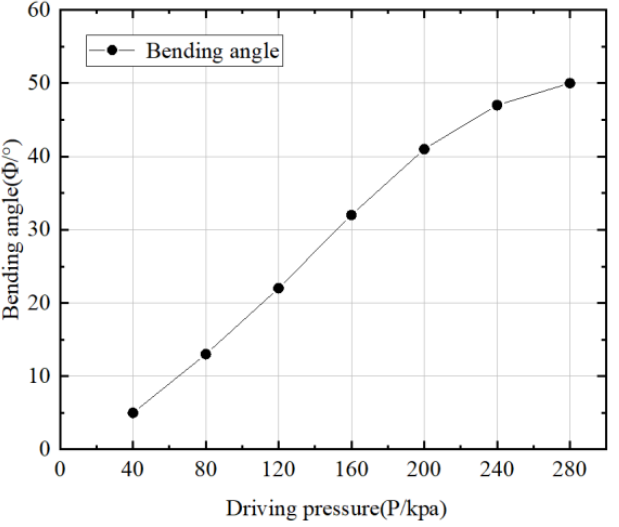
Figure 12. The characteristic curve of the hexagonal prism soft-bodied bionic actuator. It can be seen from Figure 12 that the bending angle range of the hexagonal prism ◦ soft-bodied bionic actuator is 0 − 50 . Among them, the change of P − Φ characteristic curve shows a certain linear relationship, but when the driving air pressure exceeds 200 kPa, it shows a non-linear change trend, because when the driving air pressure reaches 200 kPa, each air cavity of the rectangular cavity on the bent side begins to contact. When the pressure continues to increase, the interaction between the air cavities increases the counter bending moment of the actuator, hindering the effect of bending deformation. This can also explain the reason for the error between the simulation results and the theoretical model when the driving pressure is greater than 200 kPa.